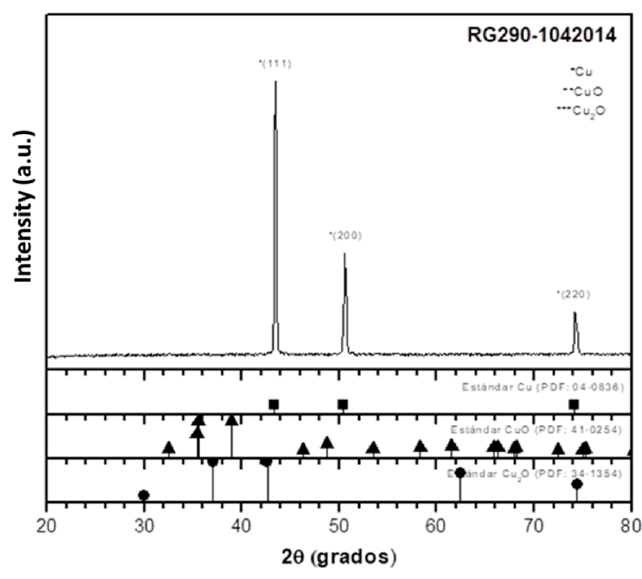
Figure 3. X-ray diffraction (SRD) patterns of Cu NPs.